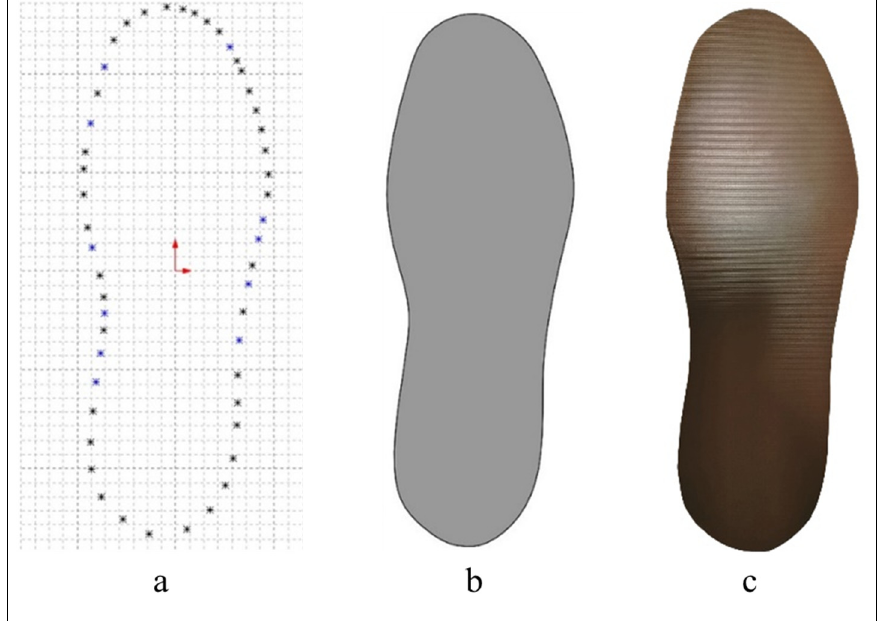
Figure 1. Geometrical modeling of insole: ( a ) insole sketch; ( b ) extruded (0.4 mm thickness); ( c ) 3D printed flexible insole.